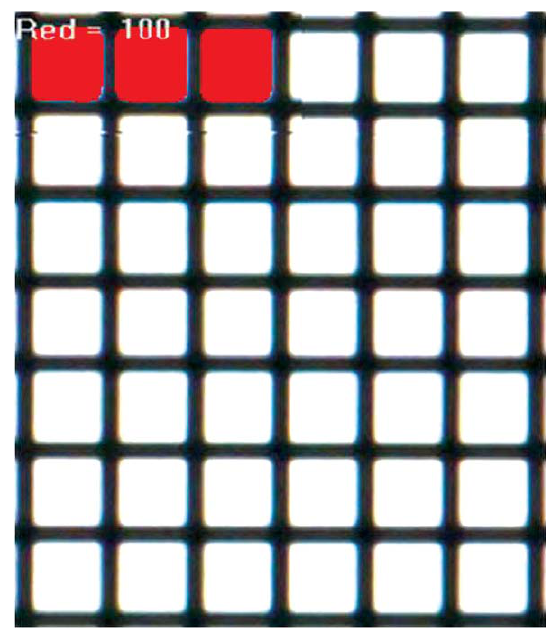
Fig. 3. Glass stage micrometer grid. A glass stage micrometer grid was scanned into a digital slide at 20 × and 40 × . Ring vectors were created to “paint” and then calculate the area of the white space of thesquares.Whileminorvariationsinthequalityofthe“painting”in theboxwasnoted,avisualexampleoftheaccuracyofthe“painting” at 40 × is shown